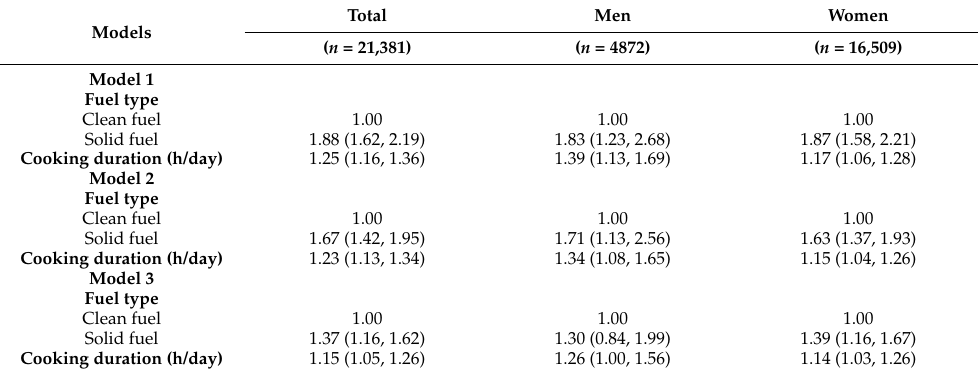
Table 2. Associations of fuel type and cooking duration with suicidal ideation.